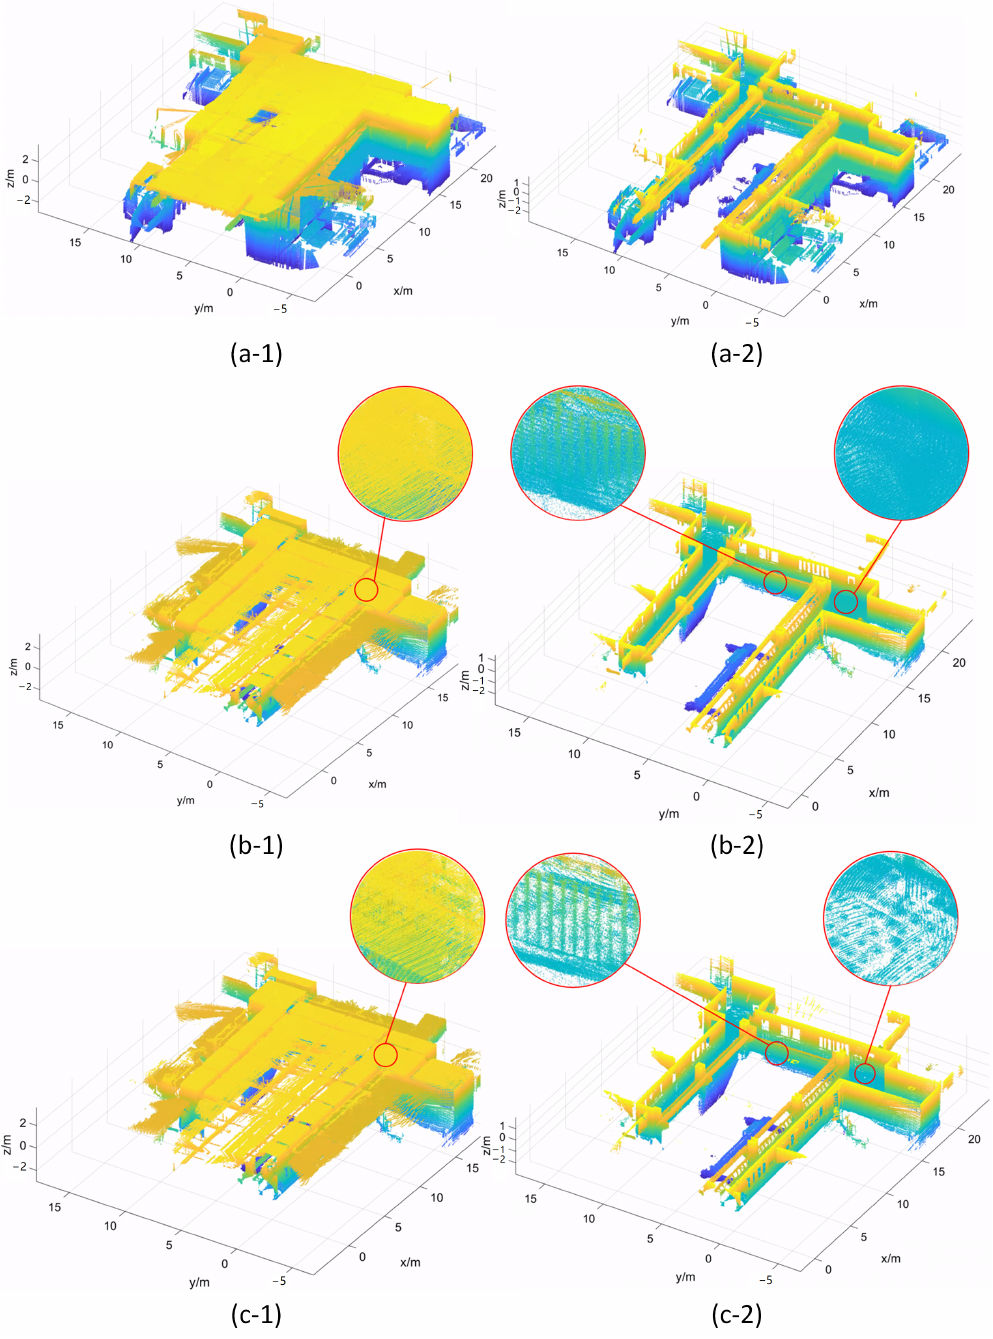
Figure 7. The result of the corridor environment mapping experiment (colored by depth). ( a-1 , a-2 ) show the ground truth. ( b-1 , b-2 ) show the mapping result without variable resolution strategy. ( c-1 , c-2 ) show the mapping result with variable resolution strategy. The full maps are on the left, and the interior details are on the